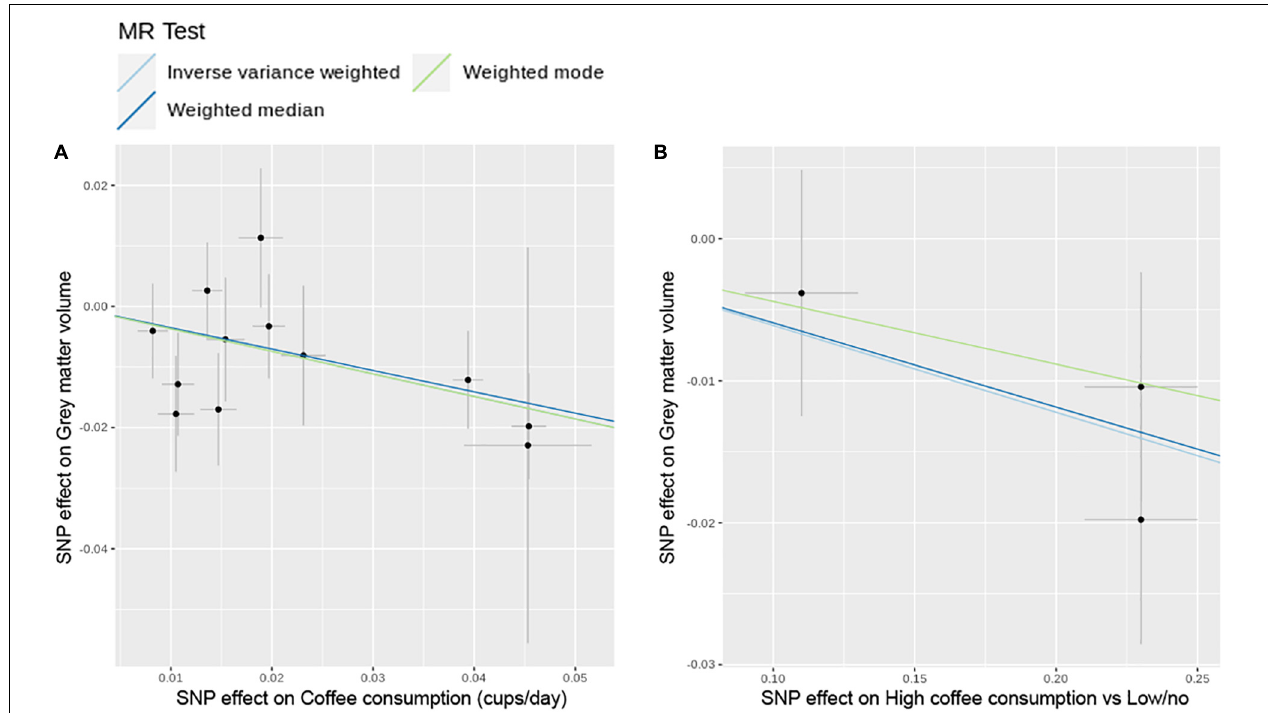
FIGURE 3 | Scatter plots of SNP effect on coffee consumption and SNP effect on gray matter volume. (A) Cups per day of coffee consumption. (B) High coffee consumption vs. low/no coffee consumption. MR, Mendelian randomization; SNP, single nucleotide